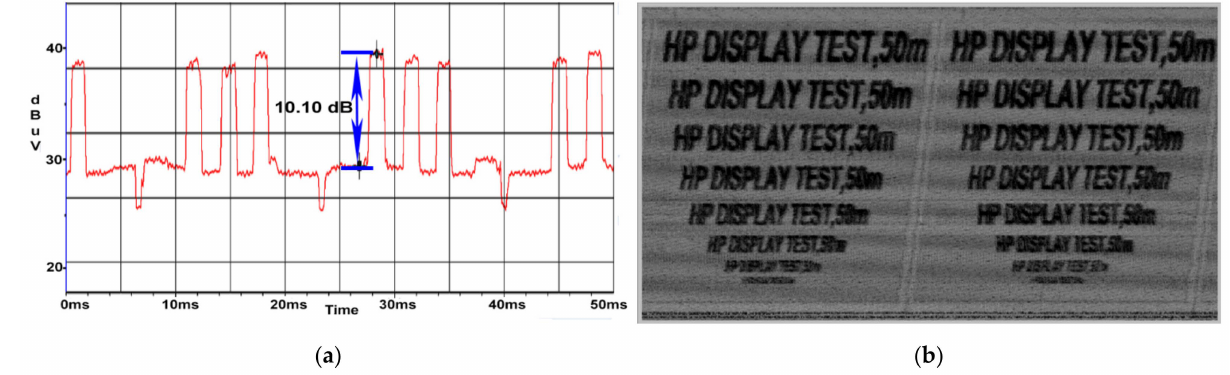
Figure 18. HP display: ( a ) SNR measured at a distance of 50 m when the cable reel was wound; ( b ) image recovered at a distance of 50 m when the cable reel was wound.